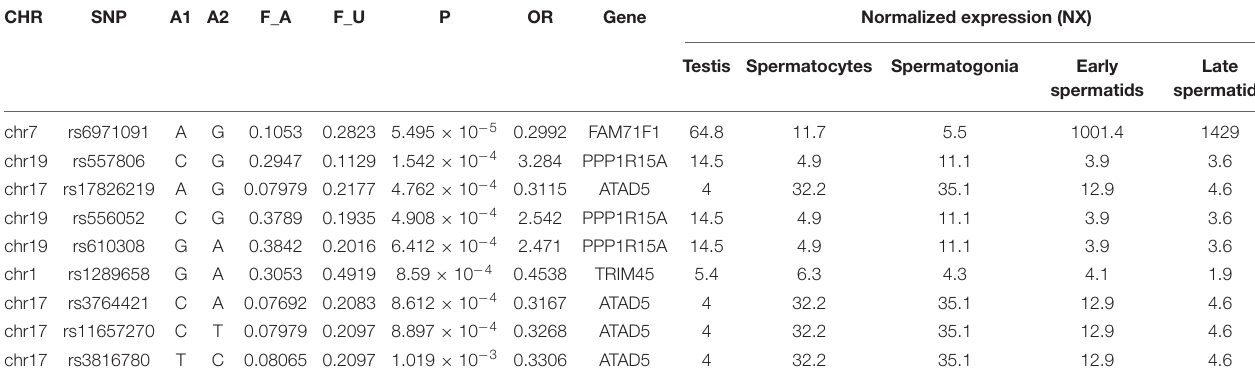
TABLE 3 | Polymorphisms obtained as a result of the association analysis ( p -value < 10 − 3 ) of the joint set using the χ 2 test with high or moderate impact based on VEP results and localized in the genes expressed in testes ( > 1NX).